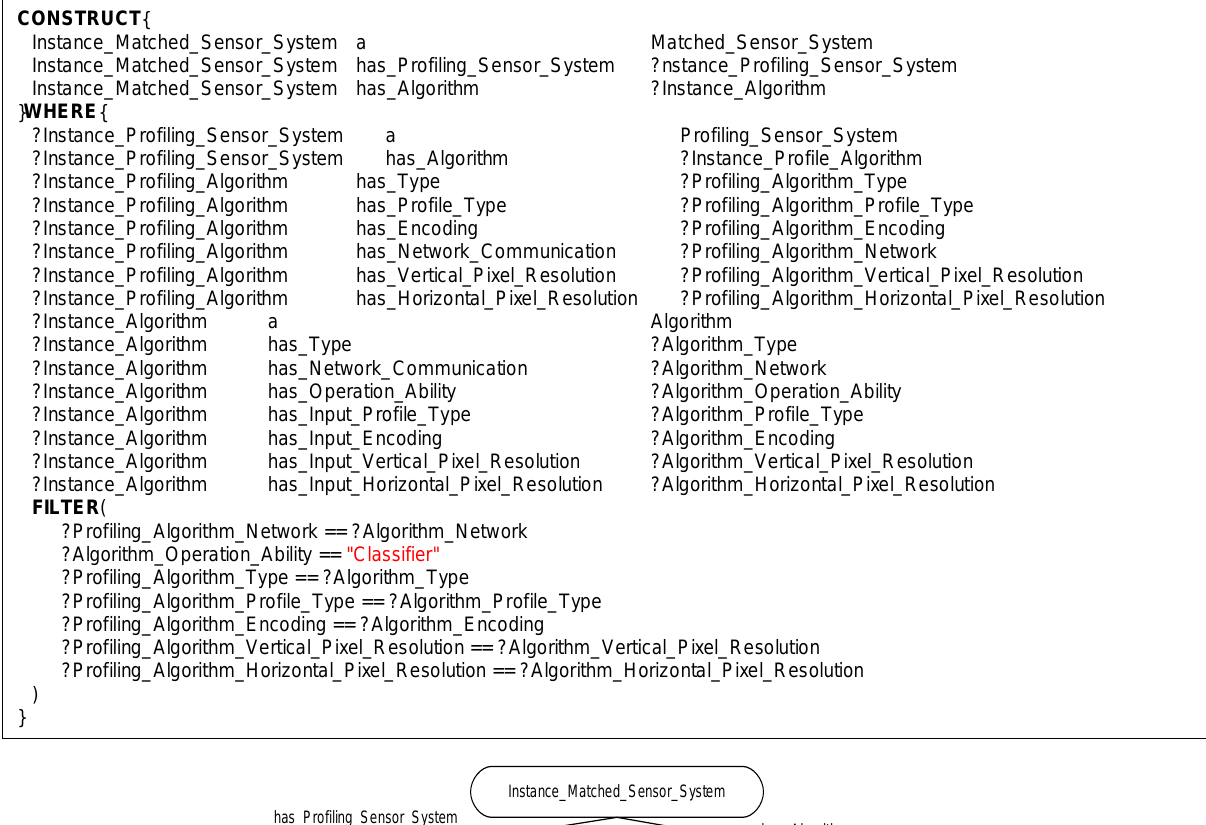
Figure 18. Sample Matched_Sensor_System rule and instance diagram. The rule returns an instance if the Profiling_Sensor_System instance and Algorithm instance properties: network communication, types, encoding, classification, and pixel resolutions are